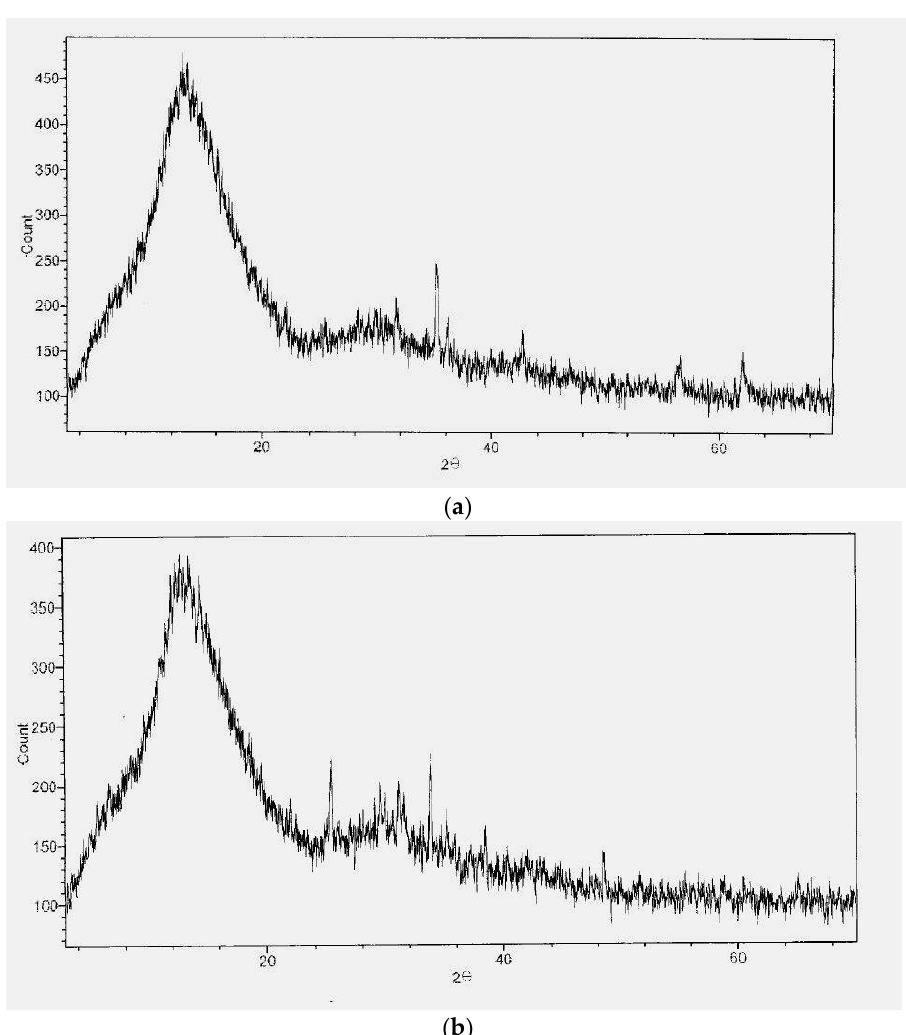
Figure 4. Results of XRD analysis of the dust before ( a ) and after ( b ) ISV treatment.